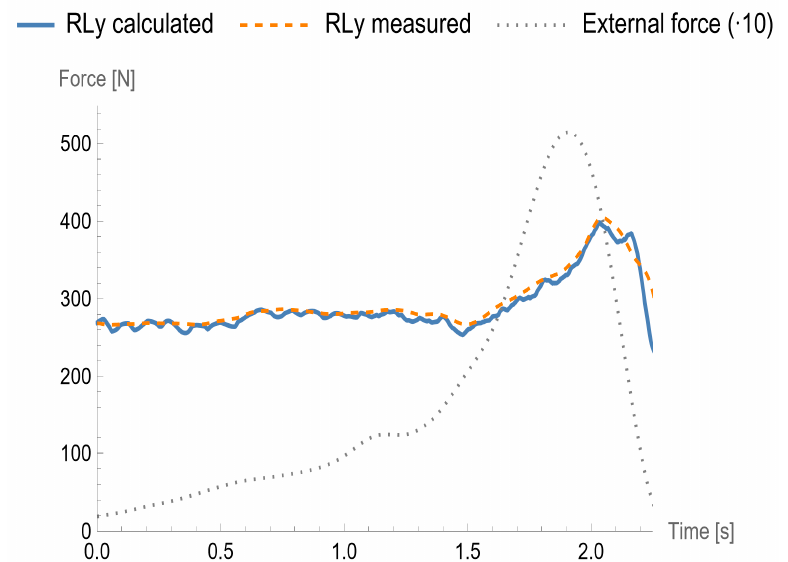
Figure 12. The vertical component, RL y , of the GRF for the left foot in the case of the external force-caused fall with a single pull. The RL y measured with the dynamometric plate is drawn using the dashed line, and the RL y calculated is drawn using the solid line. The dotted line presents the time course of the external force magnitude. The error δ = 0.0248.